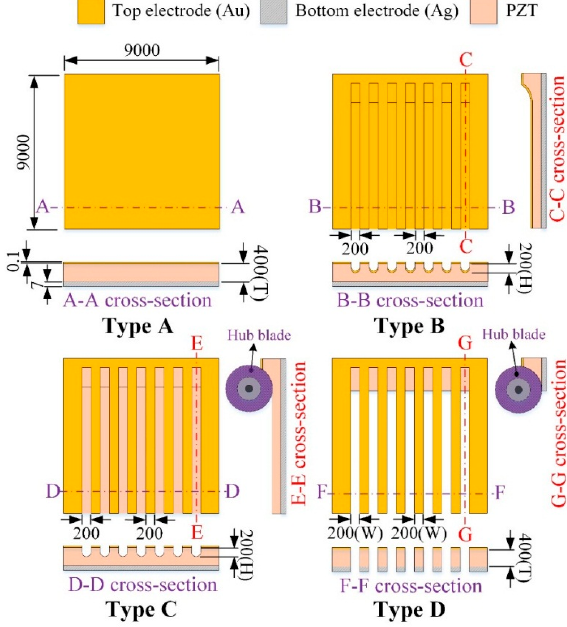
Figure 2. The pyroelectric PZT cells with various structures (unit: μ m).